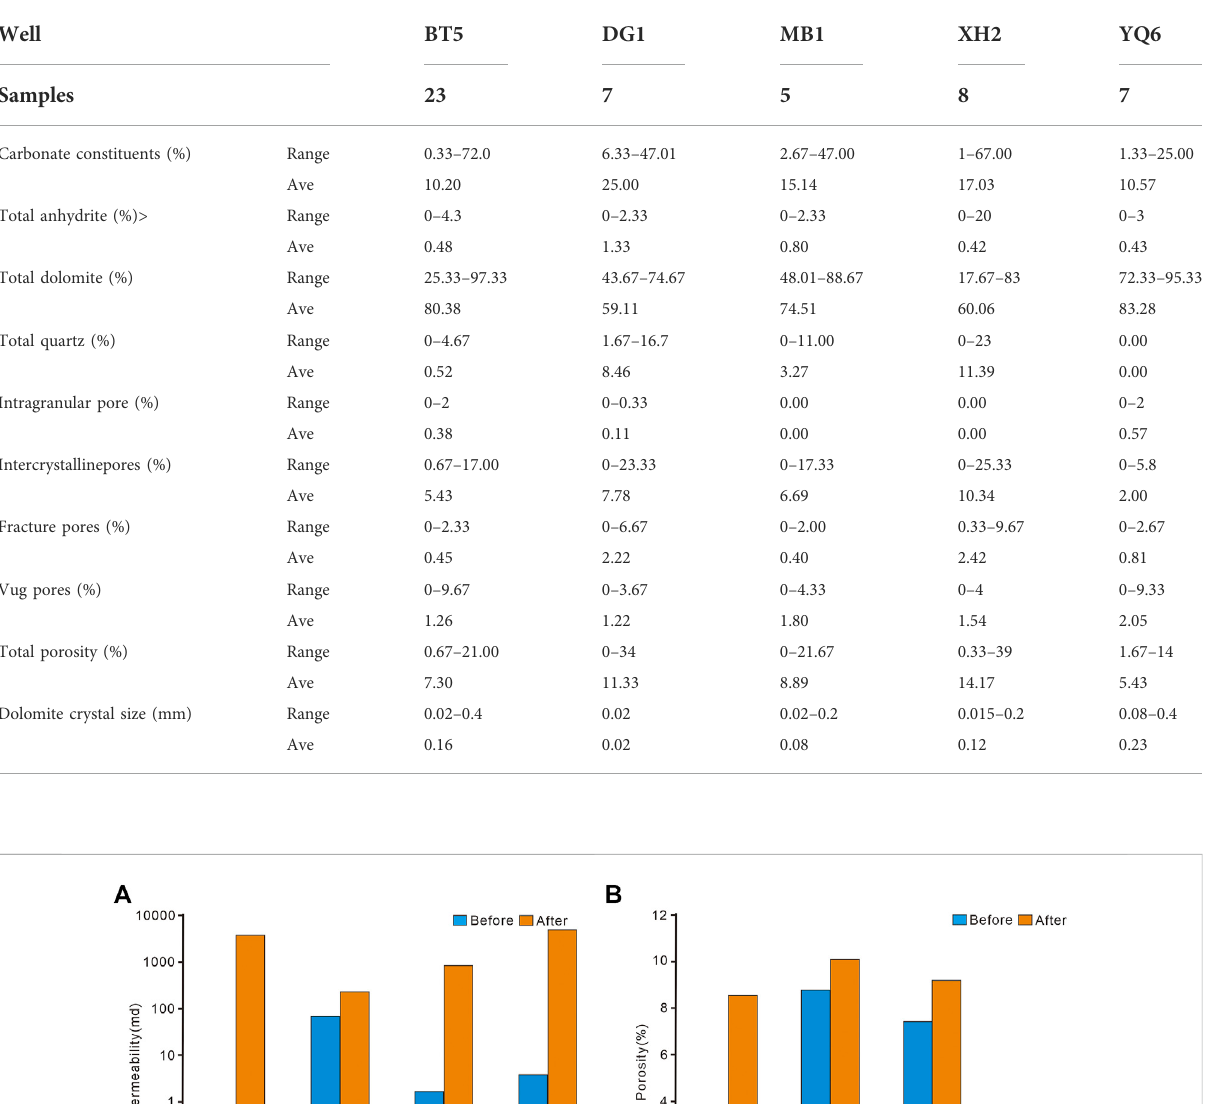
TABLE 2 Statistical table of reservoir composition of Cambrian reservoir in Tarim Basin.